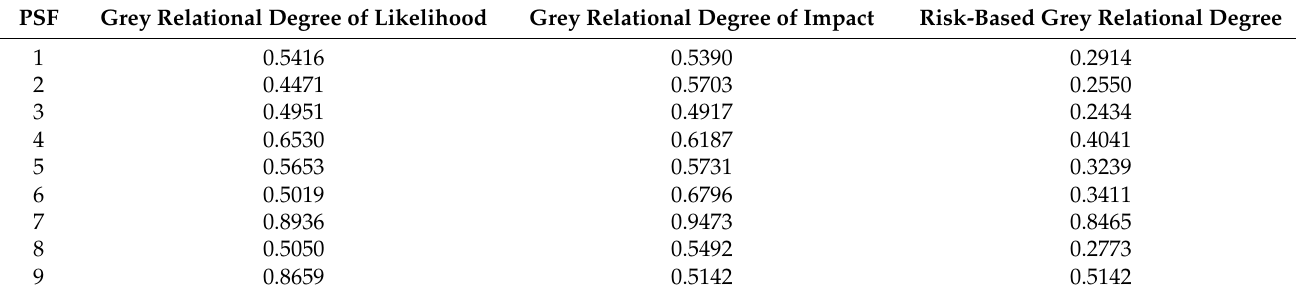
Table 11. The grey relational degree of each PSF in ST 1.1.